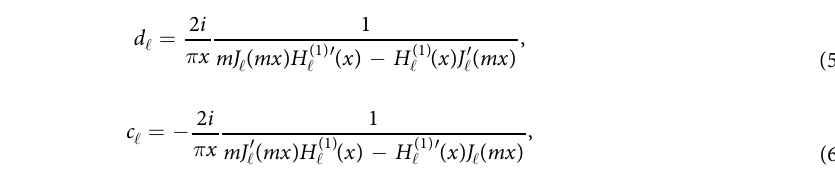
where ≡ x kR is the so-called size parameter , R stands for the radius of the cylinder;  J z ( ) denotes the Bessel func- tion of the first kind.